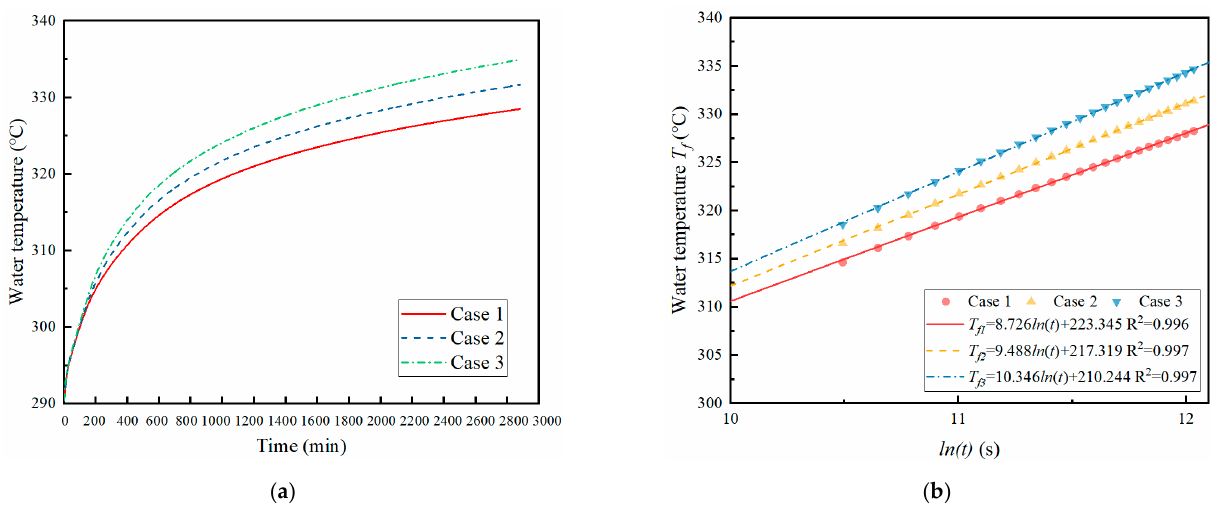
Figure 11. Average water temperatures in the HET under different cases. ( a ) Variation of average water temperature over time; ( b ) relationship between average water temperature and logarithmic time.